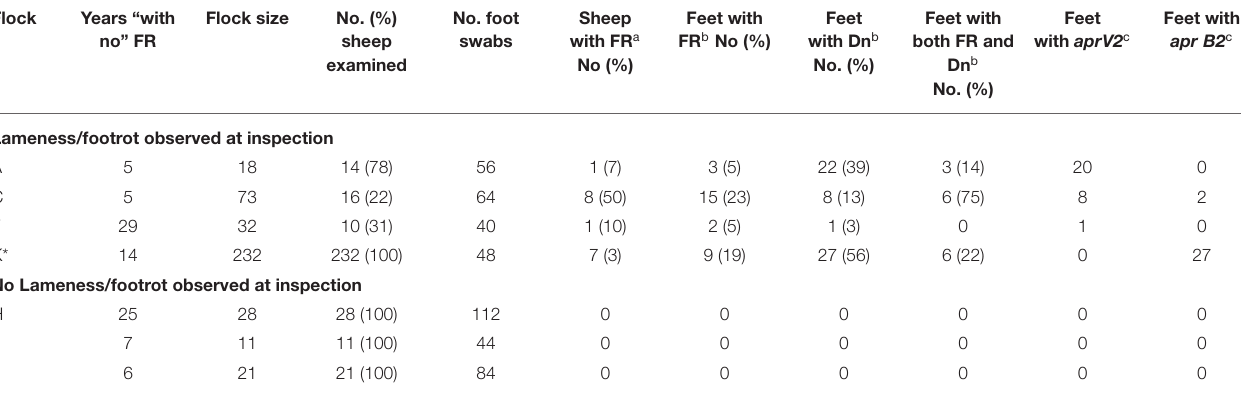
TABLE 1 | Observation of footrot and detection of D. nodosus , aprV2 and aprB2 in seven flocks in England where farmers reported “no footrot” for at least 4